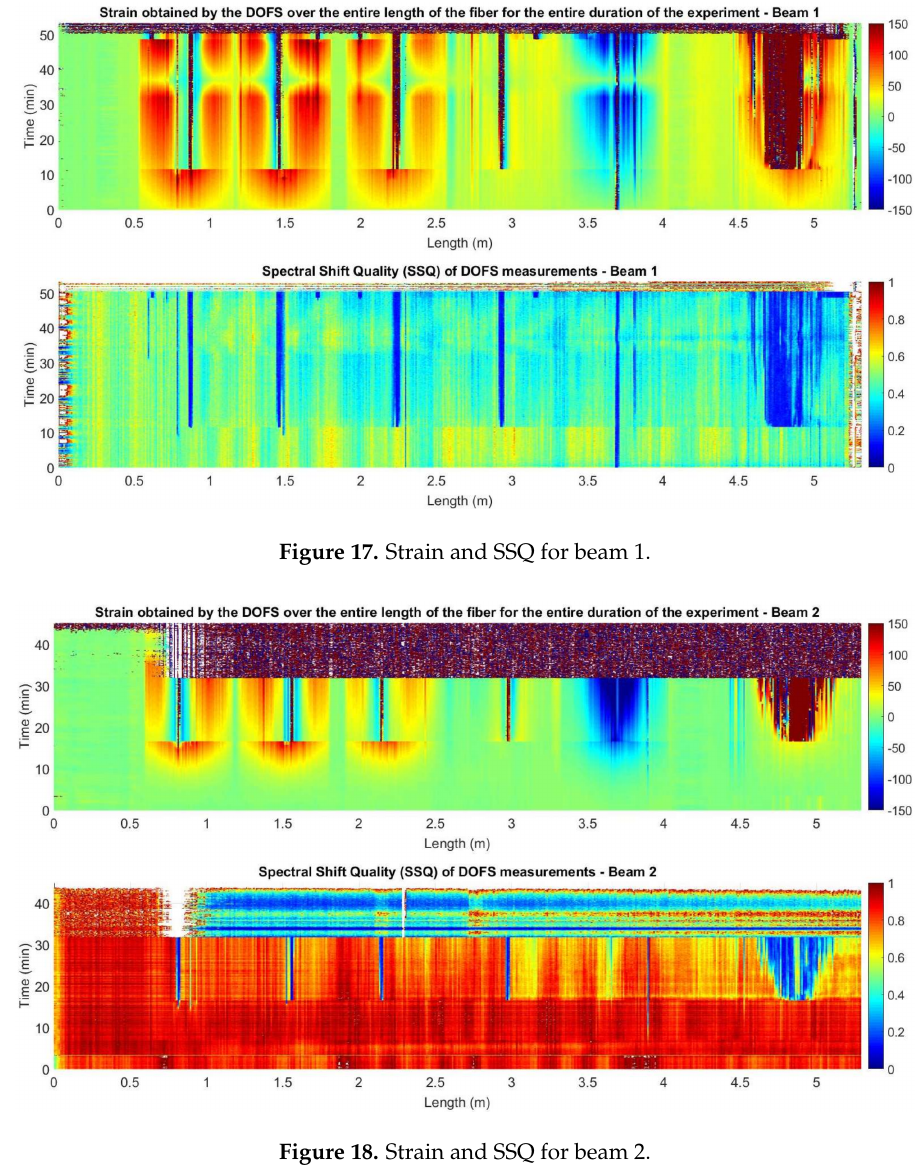
Figure 18. Strain and SSQ for beam